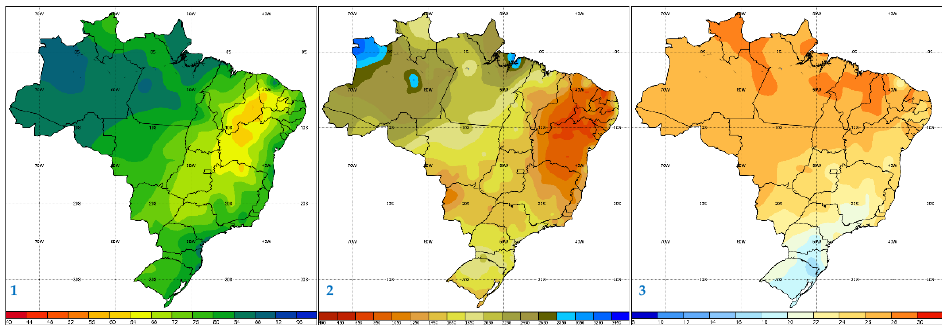
Figure 1. Brazilian climatological data, period 1981–2010: map 1 (annual average relative humidity), map 2 (annual accumulated rainfall), and map 3 (annual average temperature) (INMET 2011).